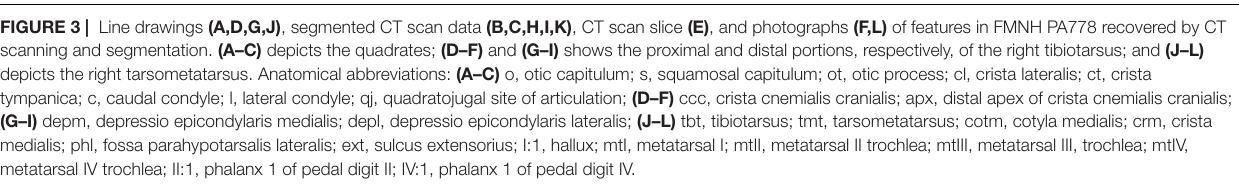
FIGURE 3 | Line drawings (A,D,G,J) , segmented CT scan data (B,C,H,I,K) , CT scan slice (E) , and photographs (F,L) of features in FMNH PA778 recovered by CT scanning and segmentation. (A–C) depicts the quadrates; (D–F) and (G–I) shows the proximal and distal portions, respectively, of the right tibiotarsus; and (J–L) depicts the right tarsometatarsus. Anatomical abbreviations: (A–C) o, otic capitulum; s, squamosal capitulum; ot, otic process; cl, crista lateralis; ct, crista tympanica; c, caudal condyle; l, lateral condyle; qj, quadratojugal site of articulation; (D–F) ccc, crista cnemialis cranialis; apx, distal apex of crista cnemialis